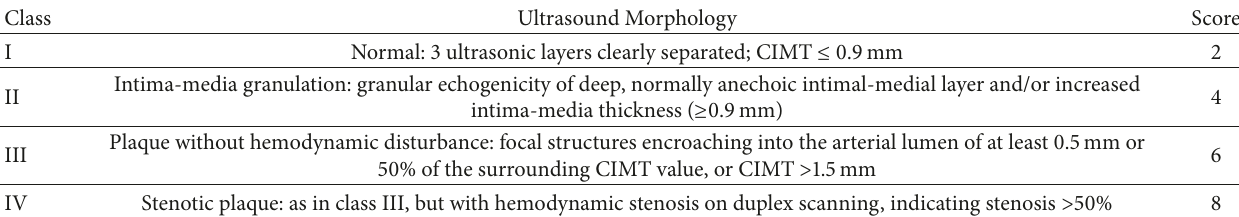
Table 2: Ultrasound morphologic classification of atherosclerotic vessel